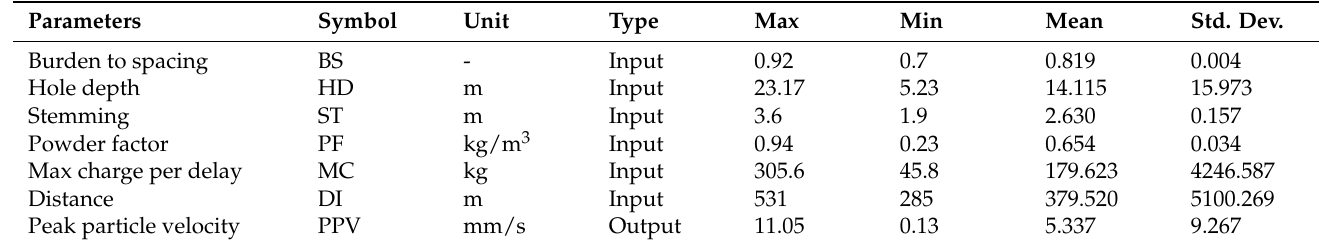
Table 2. Statistic of the data collected from the study